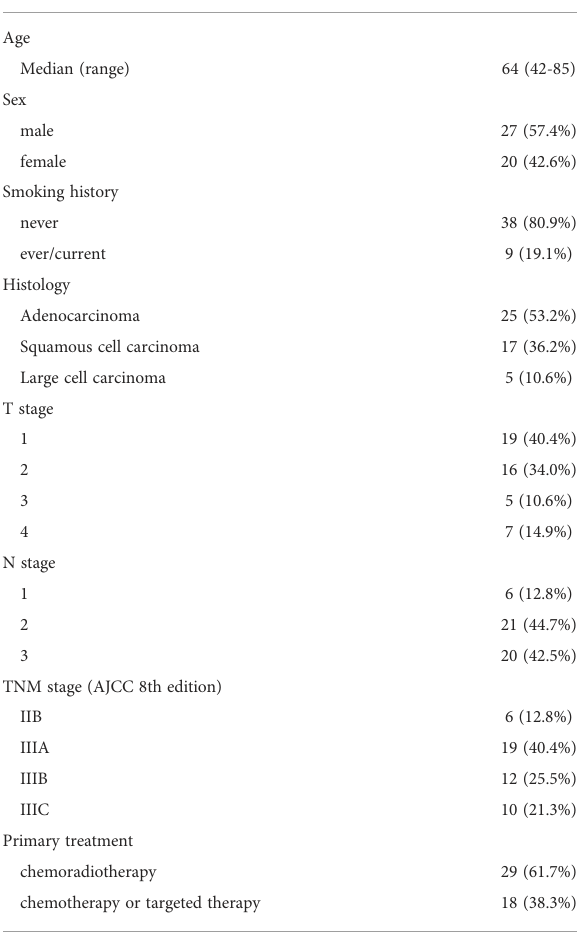
TABLE 1 Demographic and clinical characteristics of the